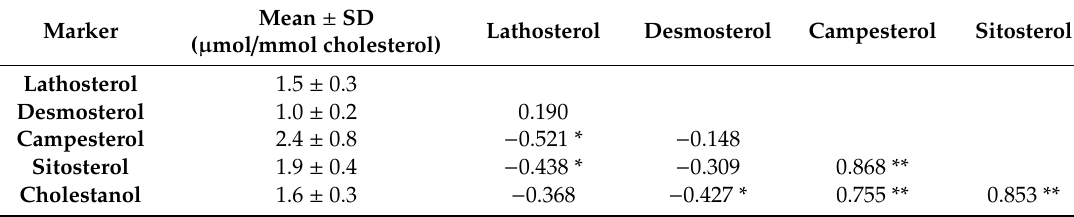
Table 2. Mean ± standard deviation (SD) and correlations between cholesterol-standardised markers reflecting endogenous cholesterol synthesis and intestinal cholesterol absorption at 09:00 h on day 1 in healthy males ( n =